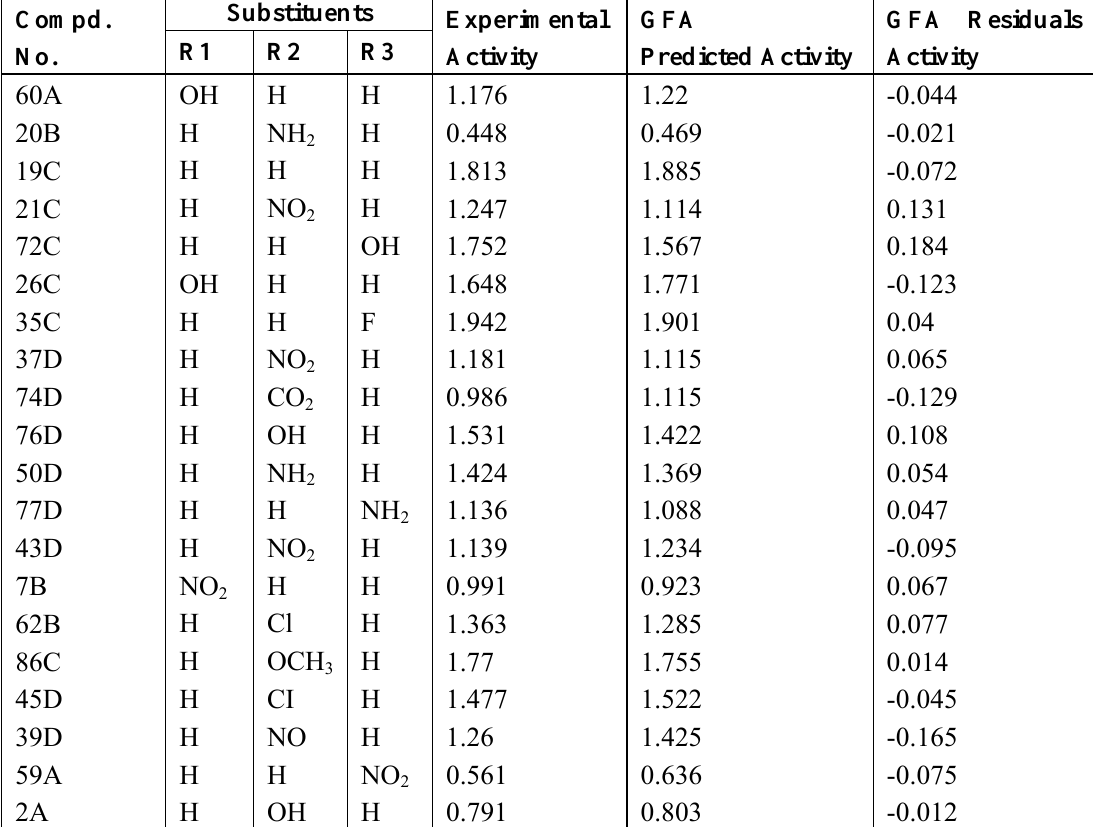
Table 3. Experimental and predicted biological activity of test set of compounds against BchE. Compd.